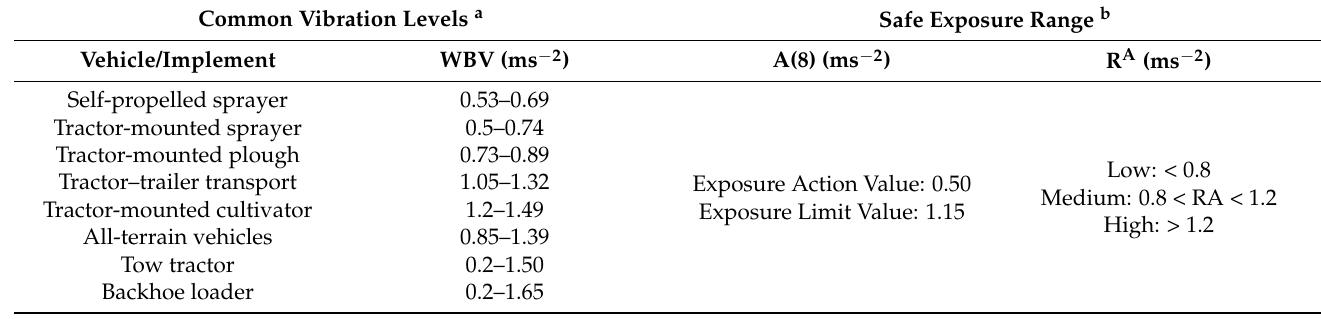
Table 5. Common vibrational exposure of agricultural vehicle during on-farm operation and a safe exposure